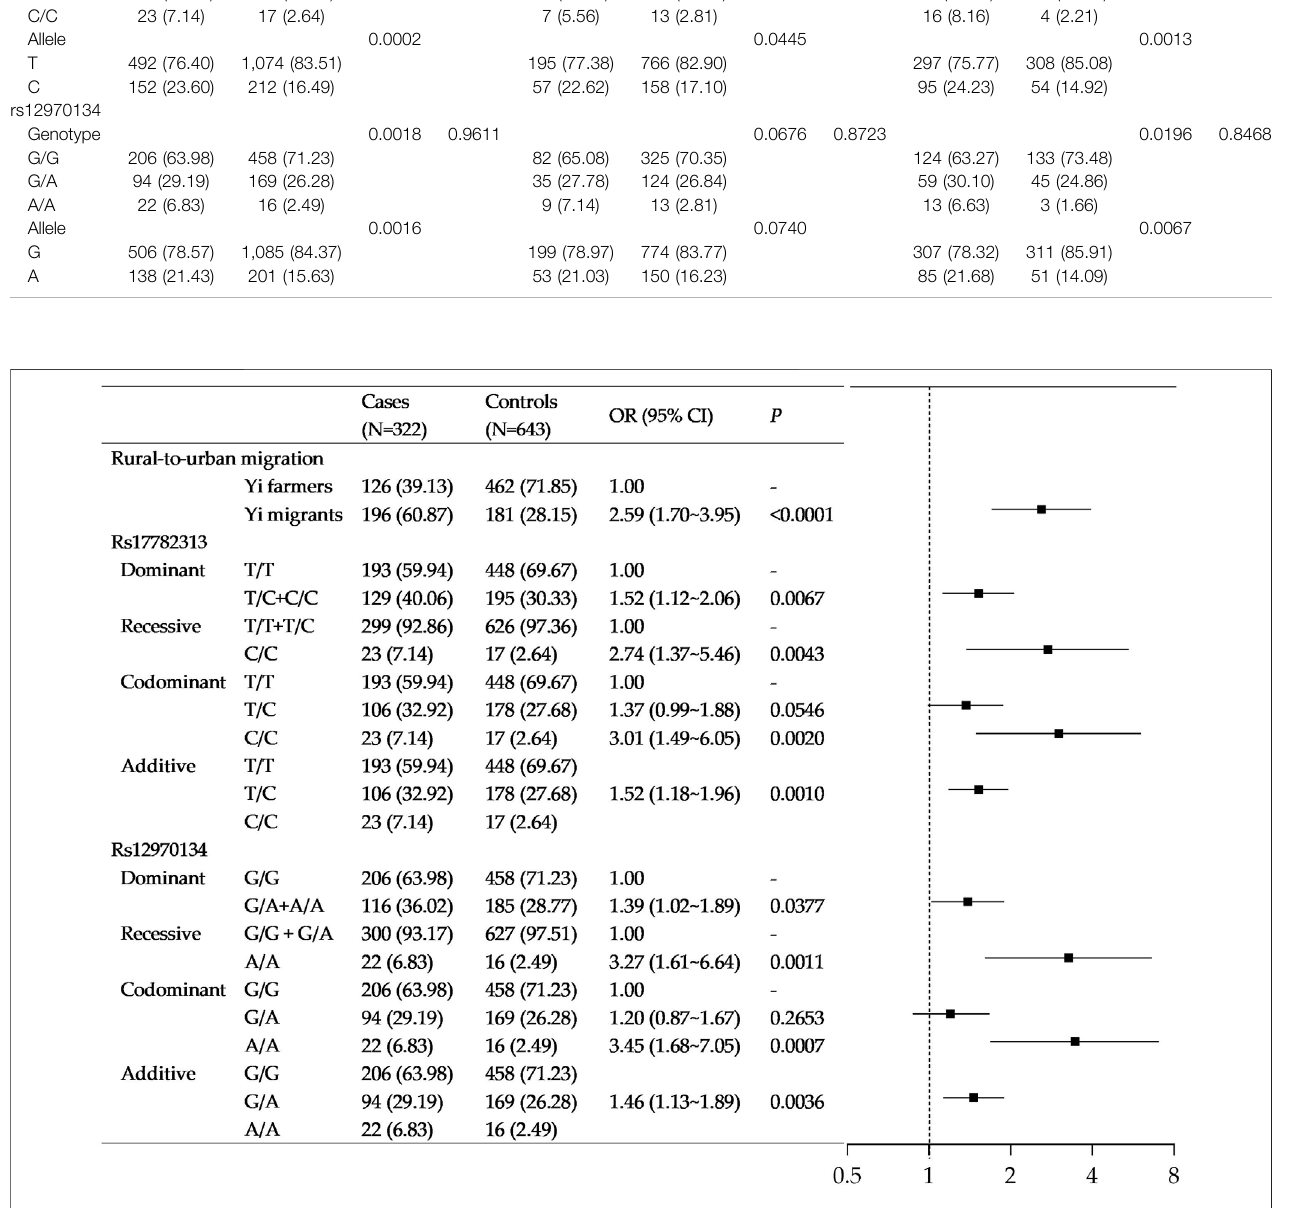
Table 1 . Among 965 Yi people, 588 were Yi farmers, and 377 were rural-to-urban migrants. Compared with the control group, cases